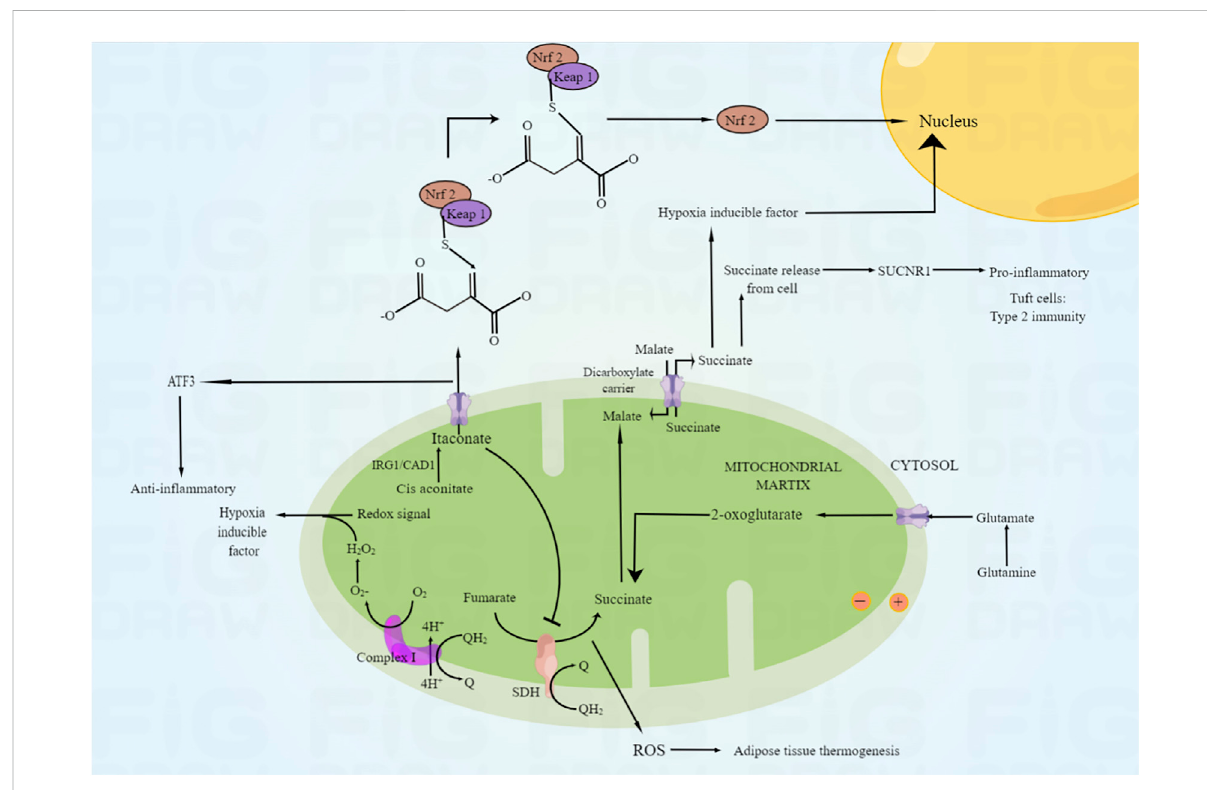
FIGURE 5 The mechanism of ROS production in mitochondria. Under the action of in fl ammation and hypoxia signal, the reverse of succinate dehydrogenase will lead to the accumulation of ischemic succinate, leading to the decomposition of purine nucleotides and the reverse of some malic acid, leading to the over fl ow of fumaric acid. After reperfusion, succinic acid was rapidly re oxidized by succinate dehydrogenase through reverse electron transport of mitochondrial complex I, and a large amount of ROS was